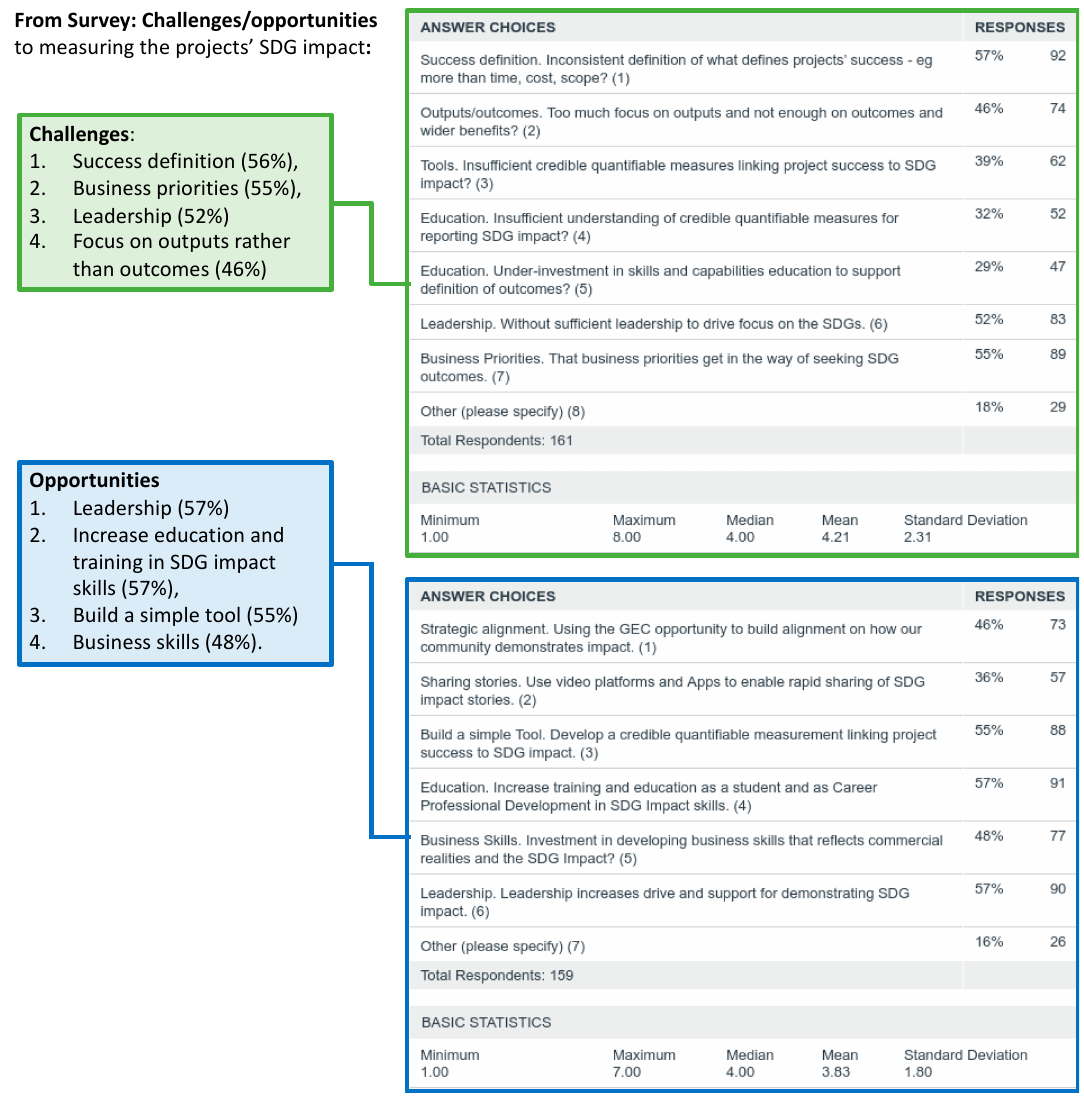
Figure 15. Responses to Question 6 (opportunities) and 7 (challenges) for measuring SDG impact? (See Appendix B for full data) .